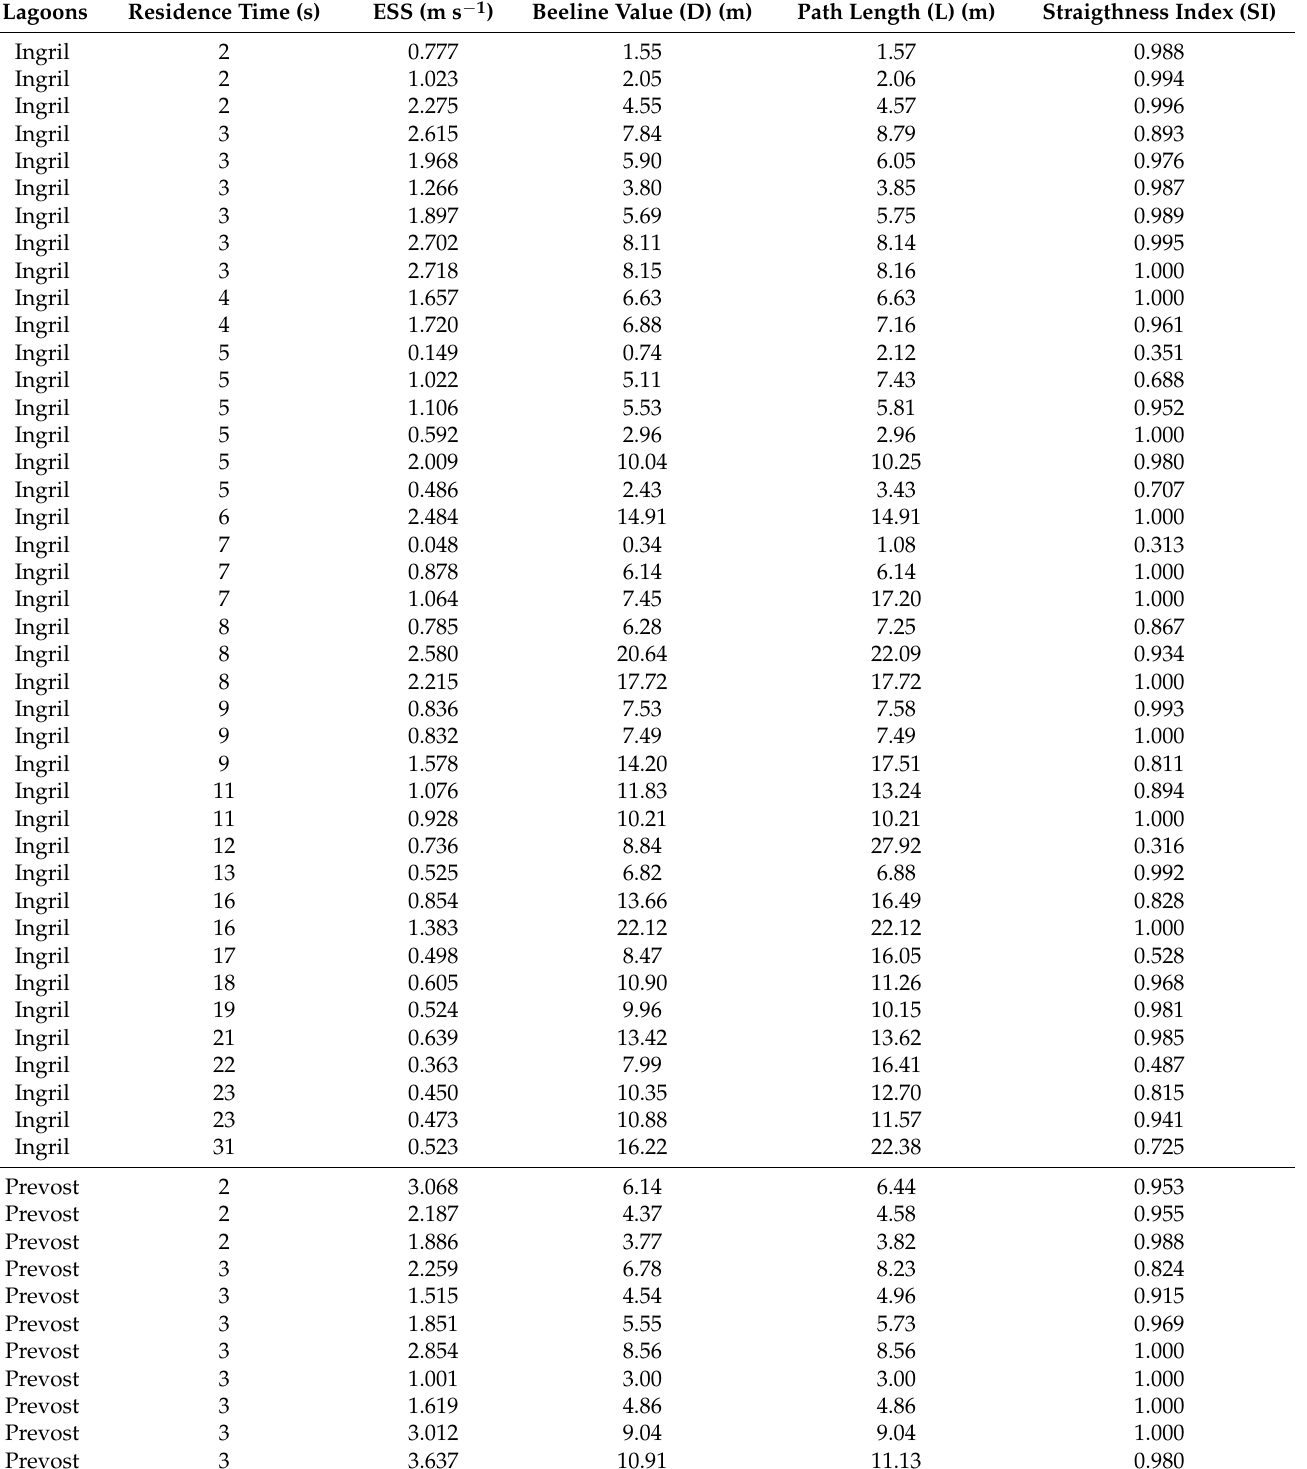
Table A1. Raw experimental data used for this study and extracted from [8,9], the Straightness index (SI) was the Beeline value divided (D) by the Path Length (L), calculated as SI = D/L. Below the theoretical function of limiting factor to the sampling